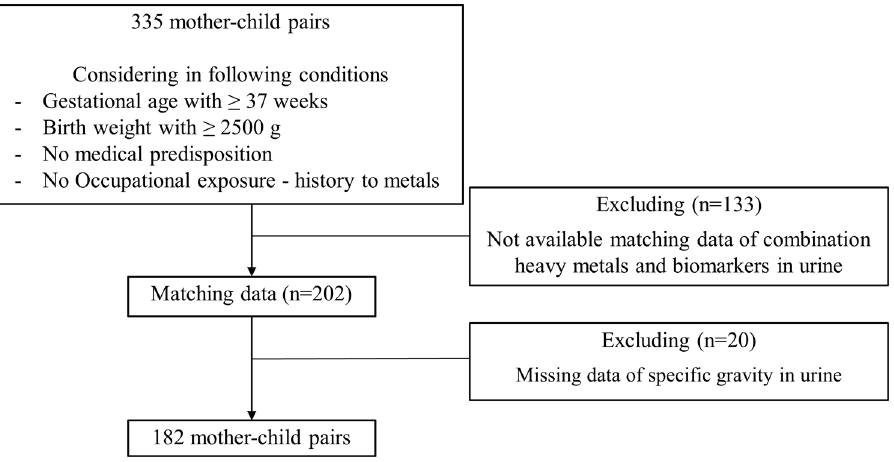
Figure 1. Flowchart showing the selection of the study population.